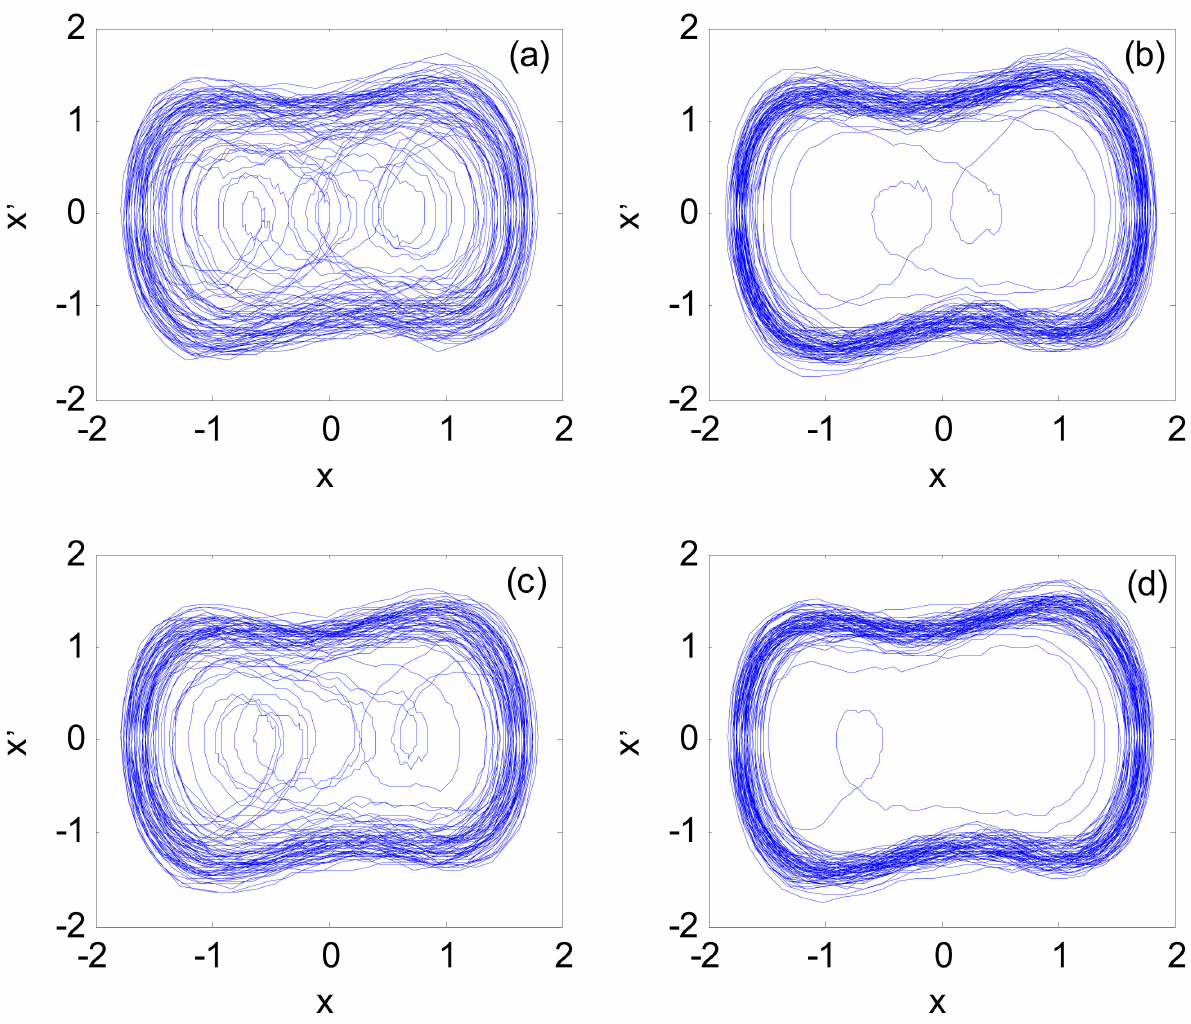
Figure 6. Phase space of the chaotic system: ( a ) while α = 0 and A a 1 = 0.800; ( b ) while α = 0 and A a 1 = 0.801; ( c ) while α = π and A a 2 = 0.850; ( d ) while α = π and A a 2 = 0.851.